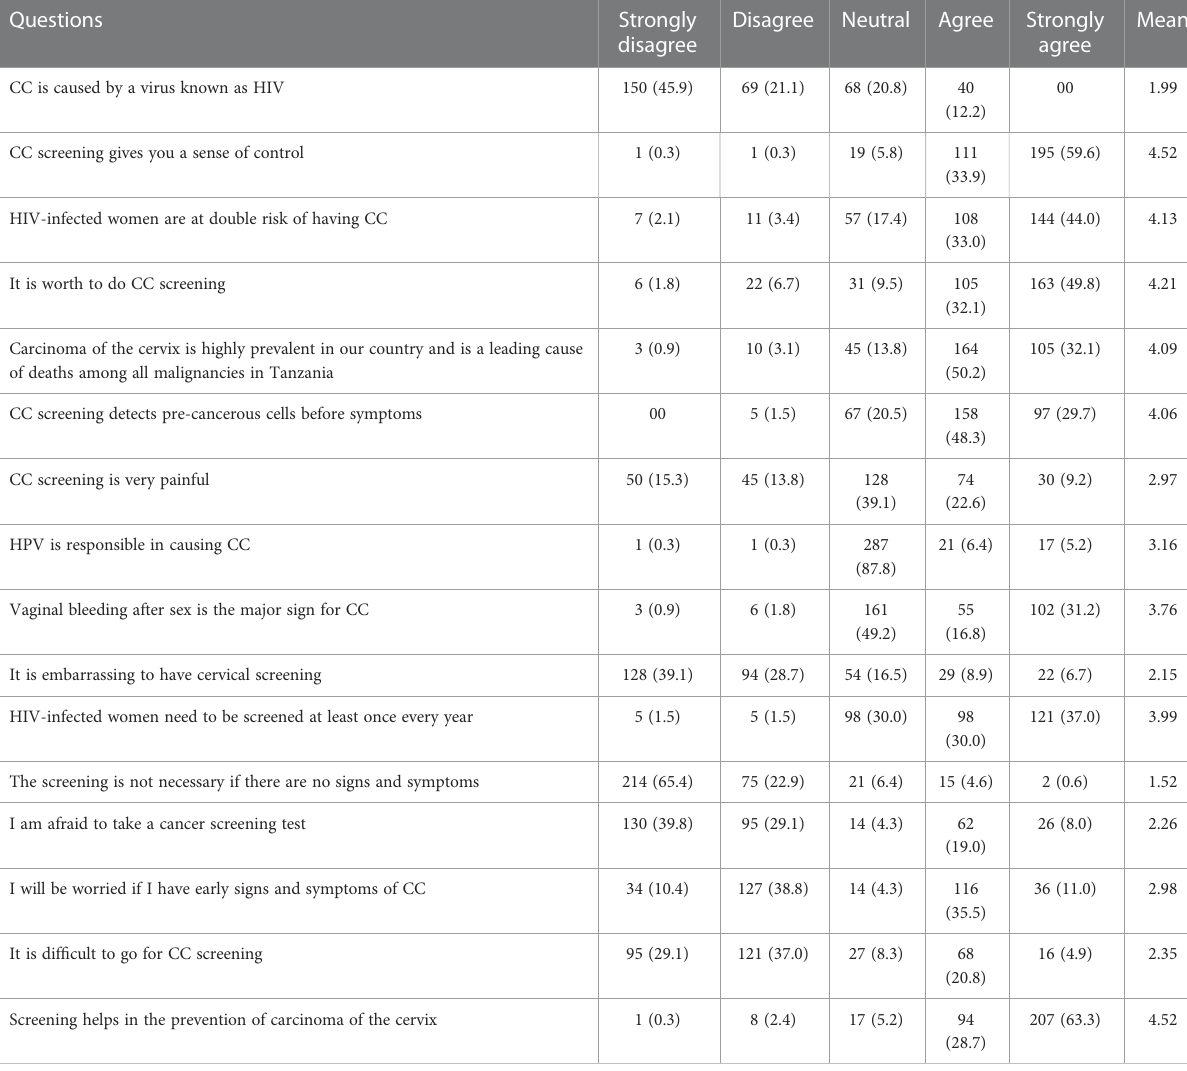
TABLE 3 Beliefs of CC and its screening services among WLHIV ( N =